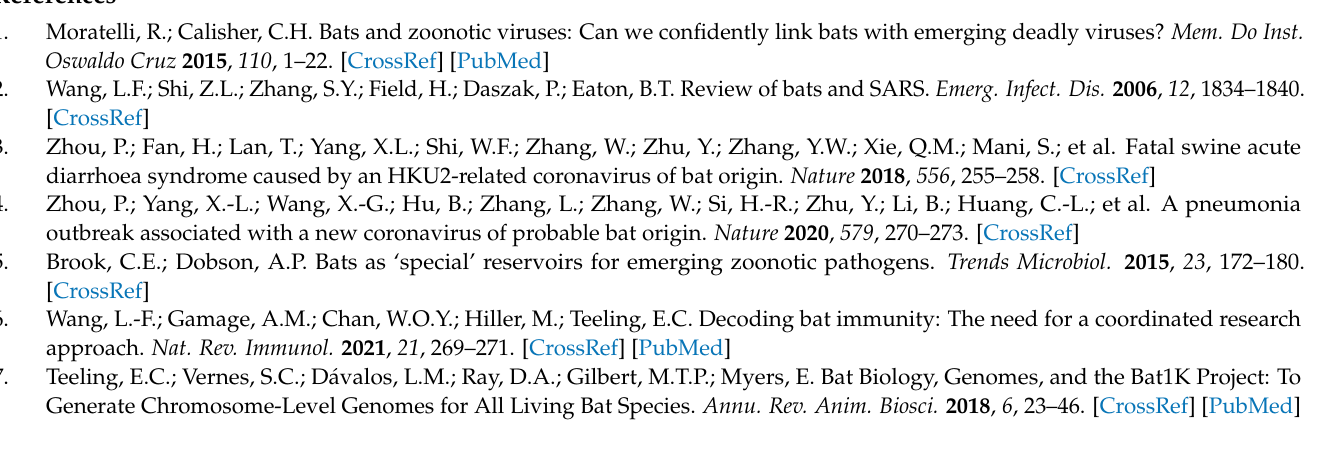
Table S2: Positive selected sites identified by PAML (M8), or HYPHY (SLAC, FEL, MEM,